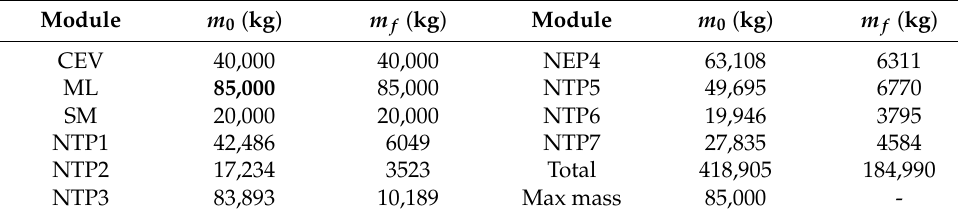
Table 16. Mass scale of